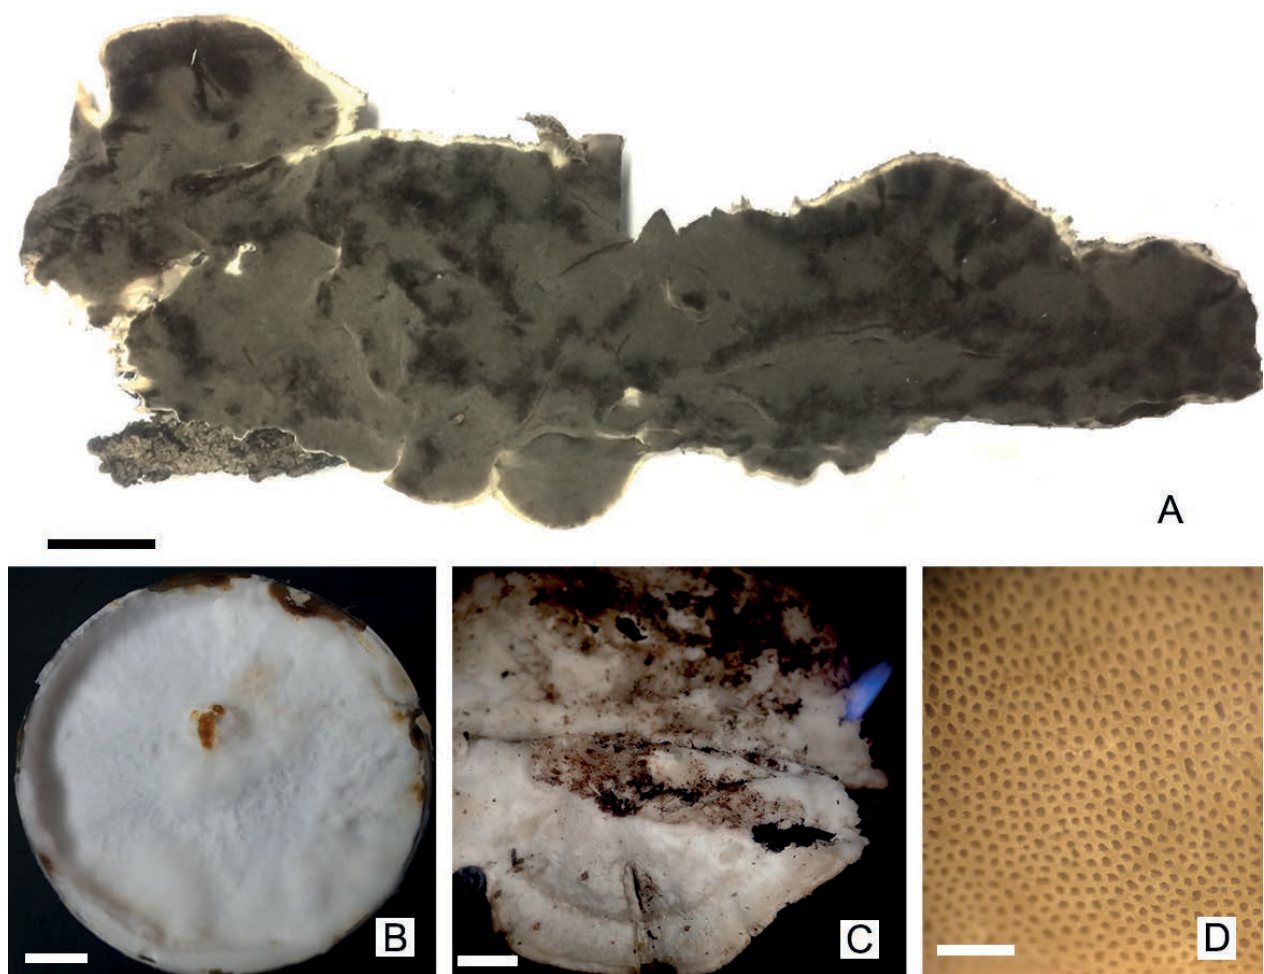
Figure 2 – Bjerkandera albocinerea (SP466870 – holotype). A . Basidiomata. B . Mycelial growth after six weeks in MEA (MV346, CCIBt). C . Pilear surface detail. D . Poroid surface detail. Photographs by V. Motato-Vásquez. Scale bars: A, B, C = 1 cm; D = 0.5